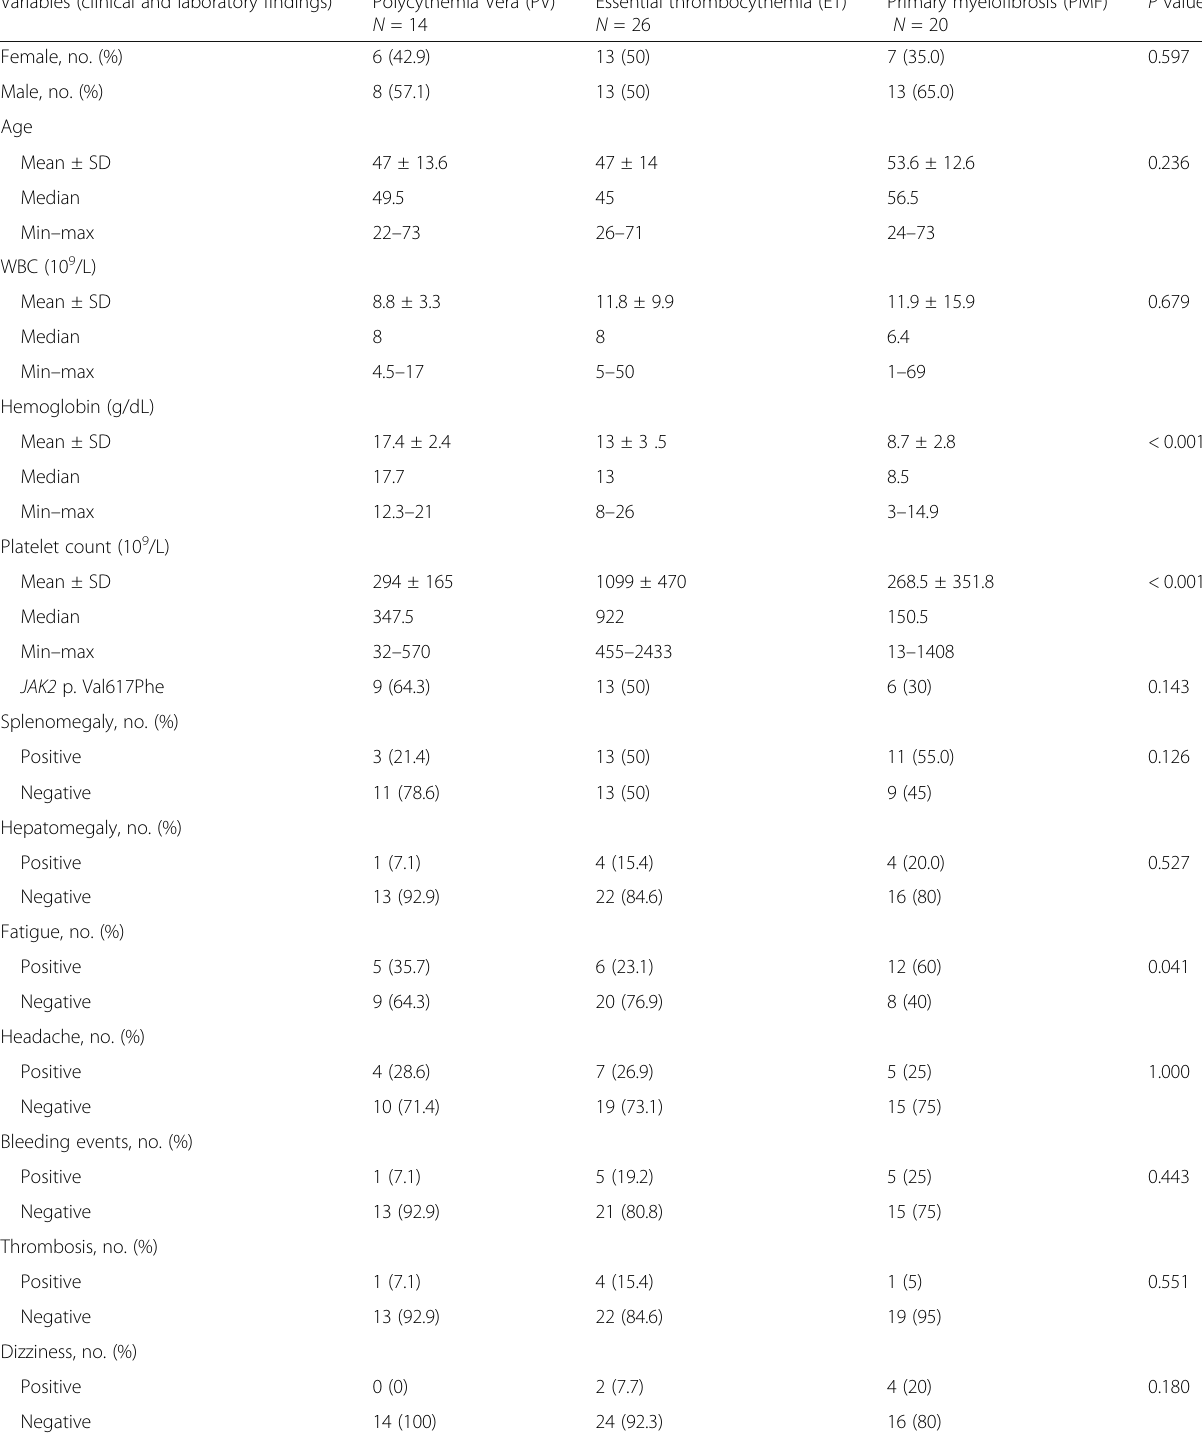
Table 3 Initial patients ’ characteristics for PV, ET, and PMF Variables (clinical and laboratory